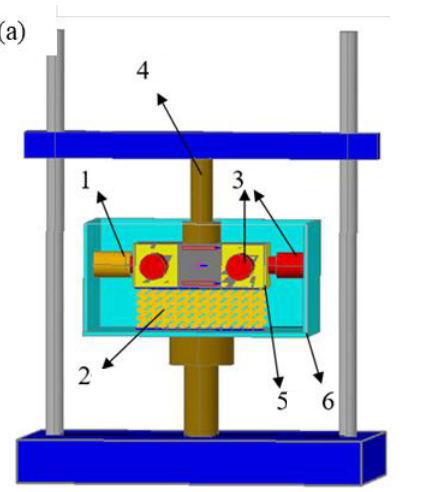
Figure 5. Test system: ( a ) Model diagram of test system: 1, lateral pressure spring; 2, bottom spring plate; 3, hydraulic golden roof; 4, MTS system; 5, contact steel plate; 6, gearbox. ( b ) Test loading diagram.